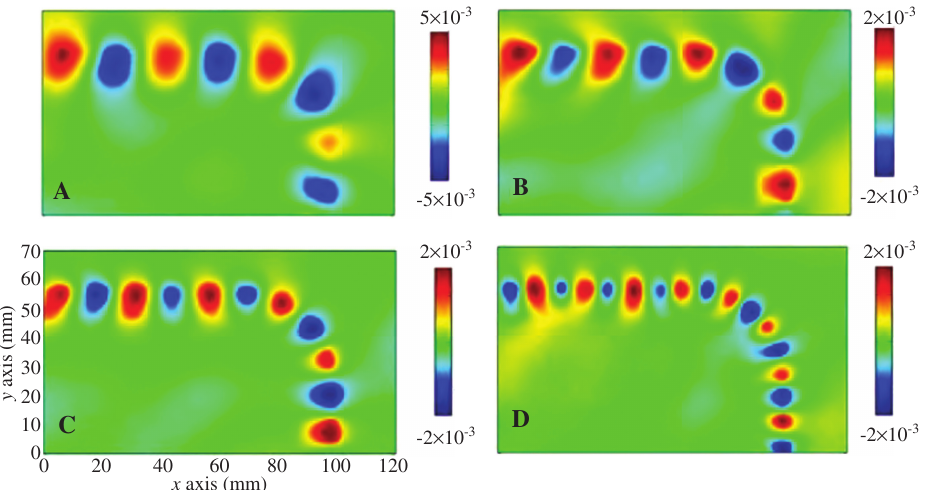
) of the planar plasmonic 90 ° bend in frequency ranging from 7 GHz to 11 GHz. (A) 7 GHz; Figure 8: Measurement results of electric fields ( E z (B) 8 GHz; (C) 9 GHz; (D) 11 GHz. Reproduced from [40] with permission.